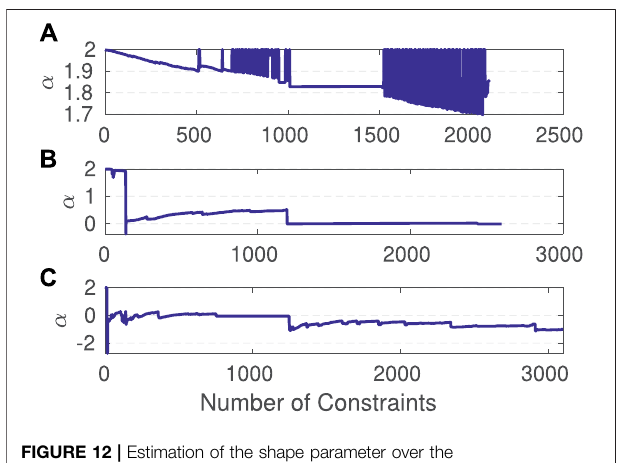
FIGURE 12 | Estimation of the shape parameter over the Manhattan3500 dataset with zero (A) , 500 (B) and 1,000 (C) outliers.